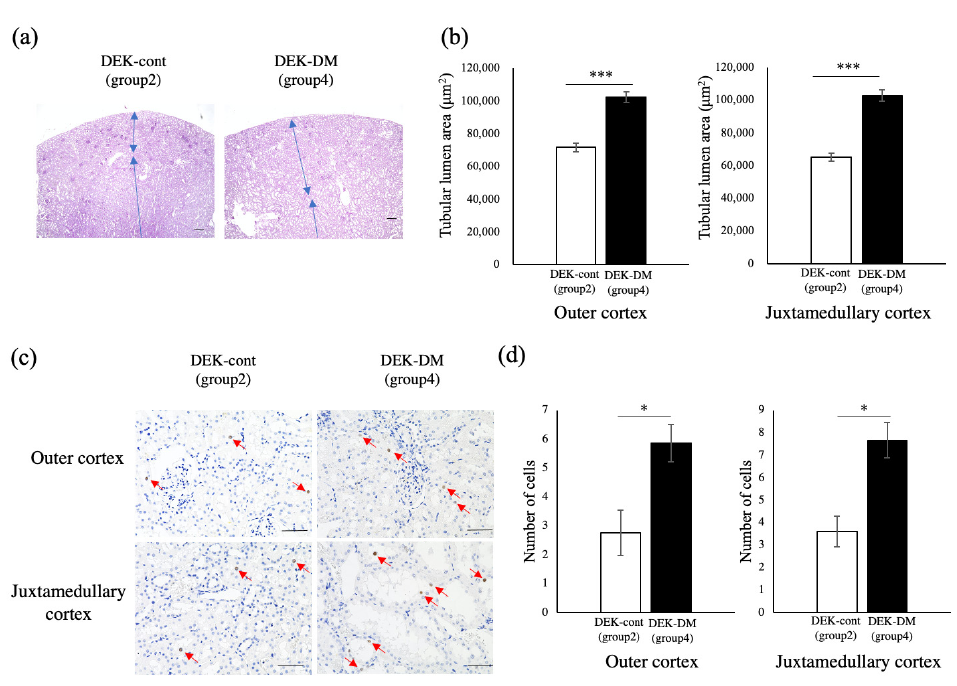
Figure 3. Histological analysis of kidney. Detailed analysis of renal histology of DEK-cont (Group 2) and DEK-DM (Group 4) rats, as categorized in Figure 2a. ( a ) Cortical areas were occupied by dilated renal tubules in DEK-DM, resulting in the number of glomerular sections appearing to be lower in DEK-DM than in DEK-cont rats. Scale bar = 200 µ m. Histologically identical areas are indicated by double-ended arrows. ( b ) Areas of tubular lumen were quantitatively compared. *** p < 0.001 for between-group differences. ( c ) Immunohistochemistry of PCNA in outer and juxtamedullary cortices. Typical PCNA-positive cells are indicated by red arrows. Scale bar = 50 µ m. ( d ) Numbers of PCNA-positive cells in ( c ). Group 2: DEK-cont rats aged 30 weeks ( n = 3). Group 4: DEK-DM rats with late-onset (>18 weeks) DM euthanized at age 30 weeks ( n = 3). * p < 0.05 for between-group differences.